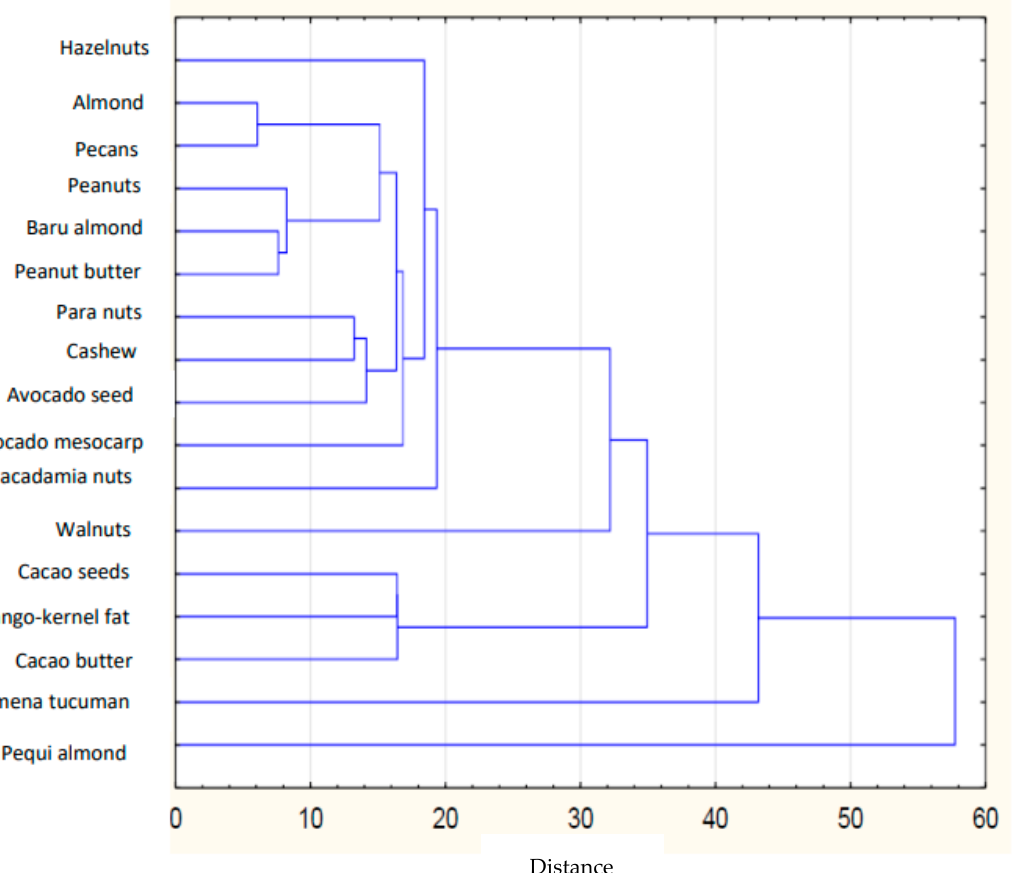
Distance Figure 7. Hierarchical cluster graph of traditional nuts. Figure 7. Hierarchical cluster graph of traditional